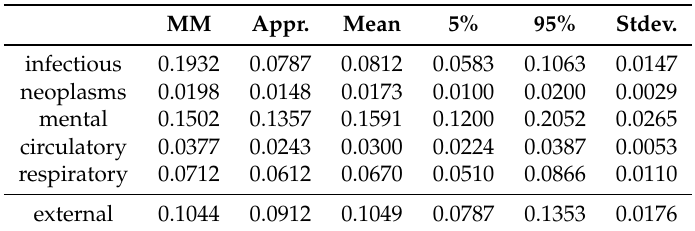
Table 2. Estimates for selected risk factor standard deviations σ using matching of moments (MM), Approximation (11) (appr.) and MCMC mean estimates (mean), as well as corresponding standard deviations (stdev.) and 5% and 95% quantiles (5% and 95%). MM Appr.